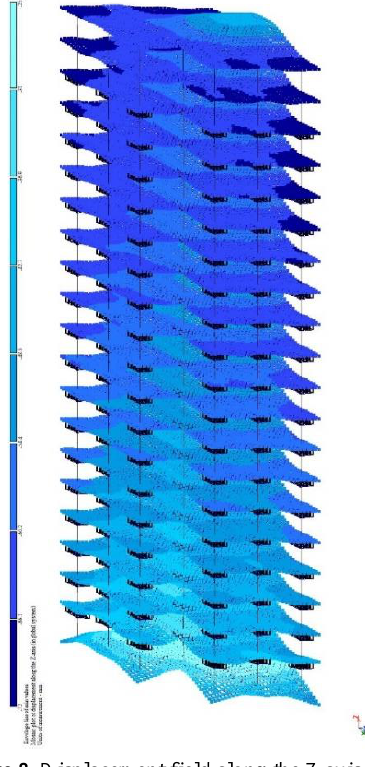
Figure 8 . Displacement field along the Z axis in mm.